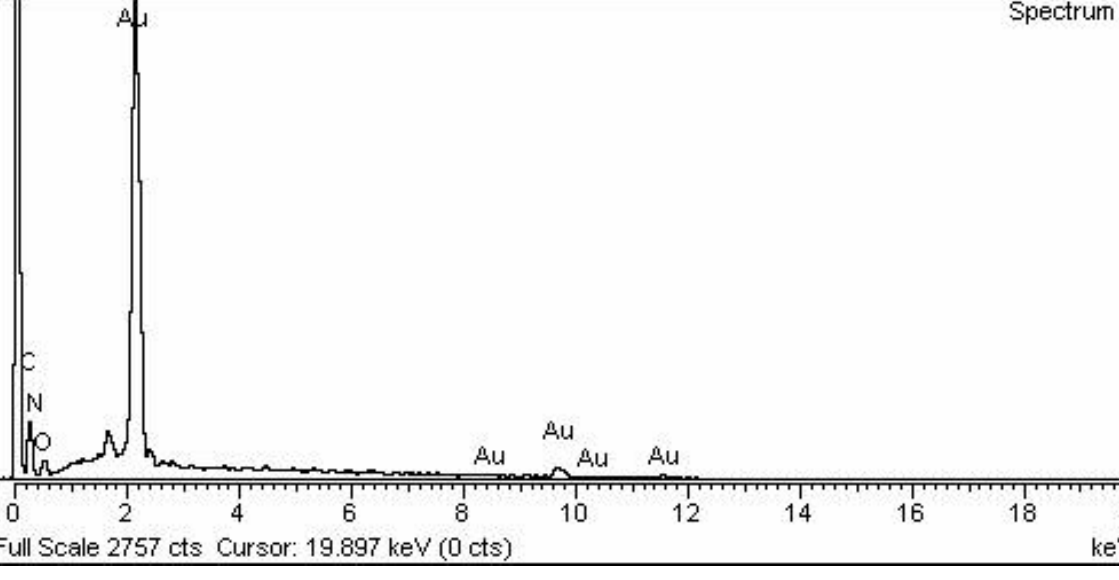
Figure 7. EDX elemental analyses of AuNPs.